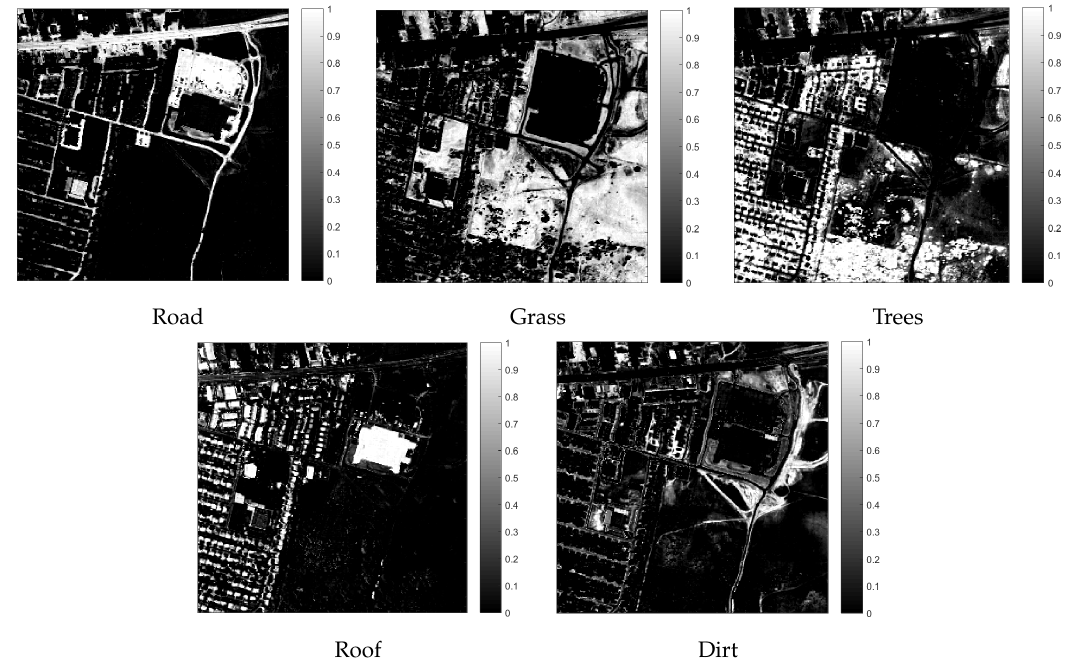
Figure 16. Urban information classes’ abundance